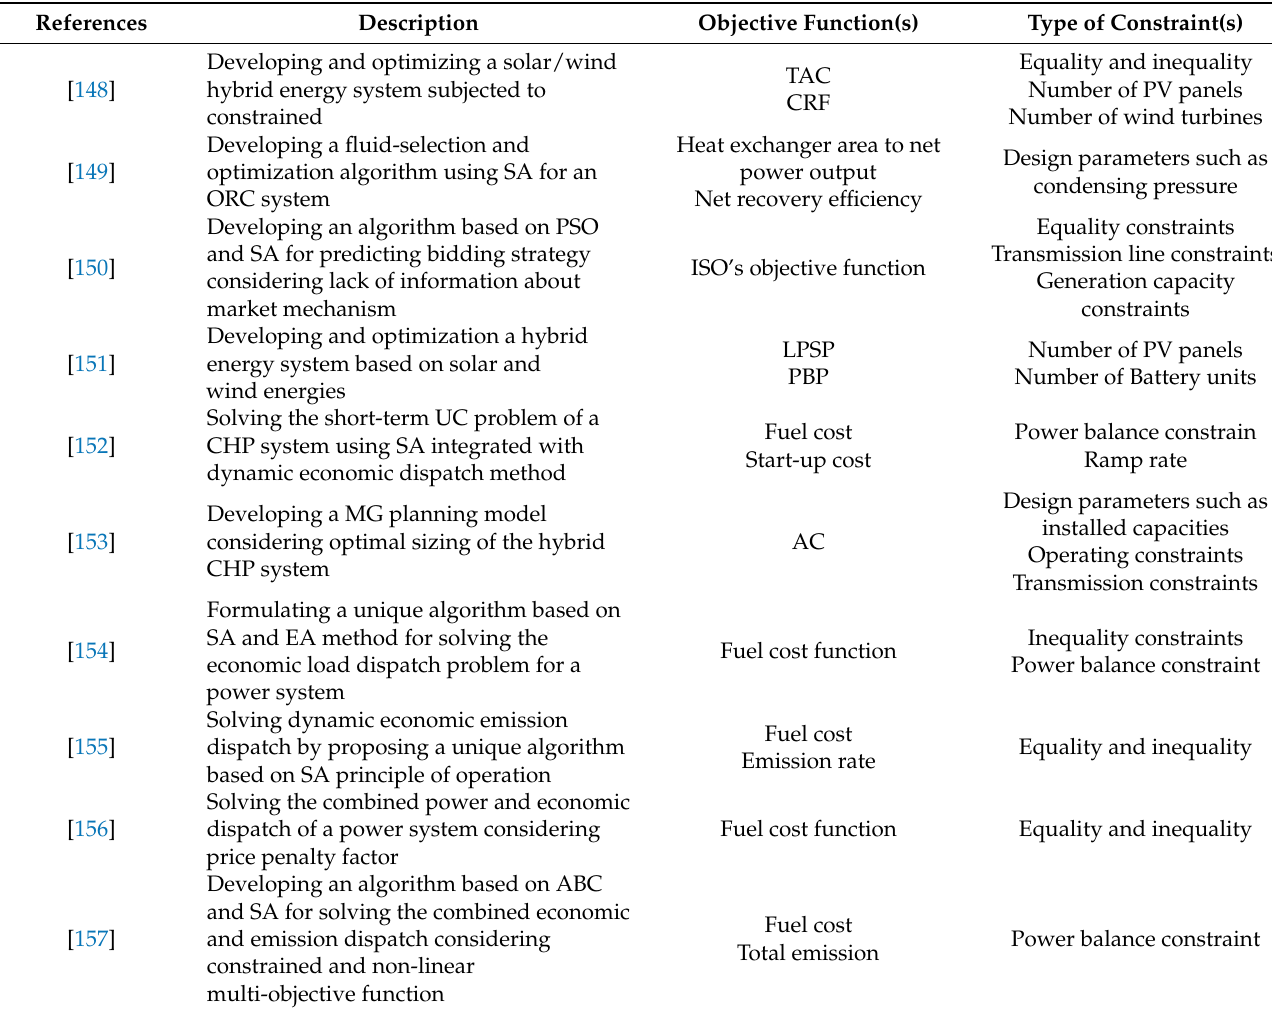
Table 3. Selected preliminary studies on energy system optimization using the SA